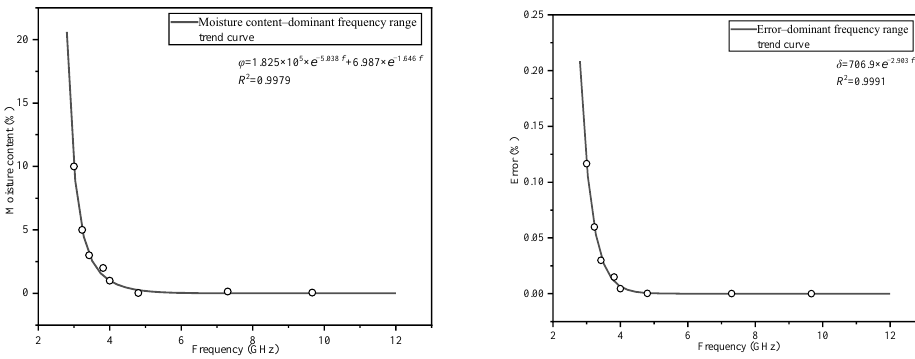
Polymers 2022 , 14 , x FOR PEER REVIEW Figure 7. Trend graph of the real part of the dielectric constant. Figure 7. Trend graph of the real part of the dielectric constant.